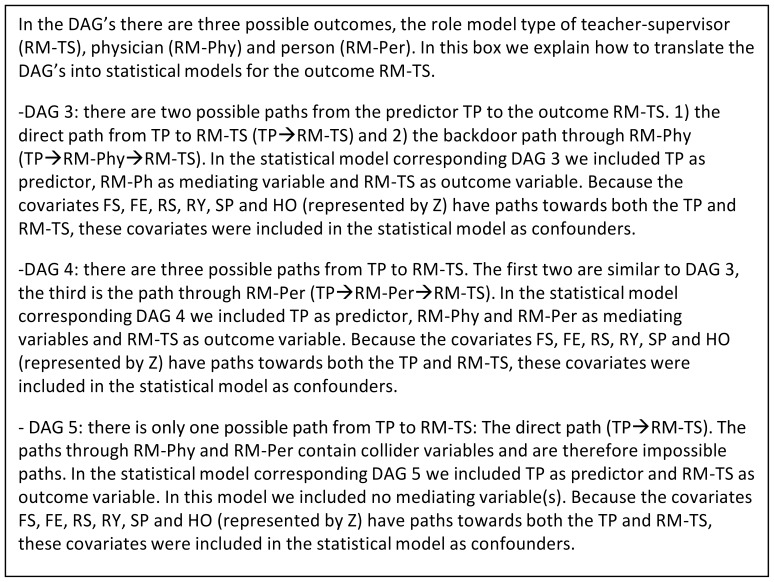
DAGs and models.